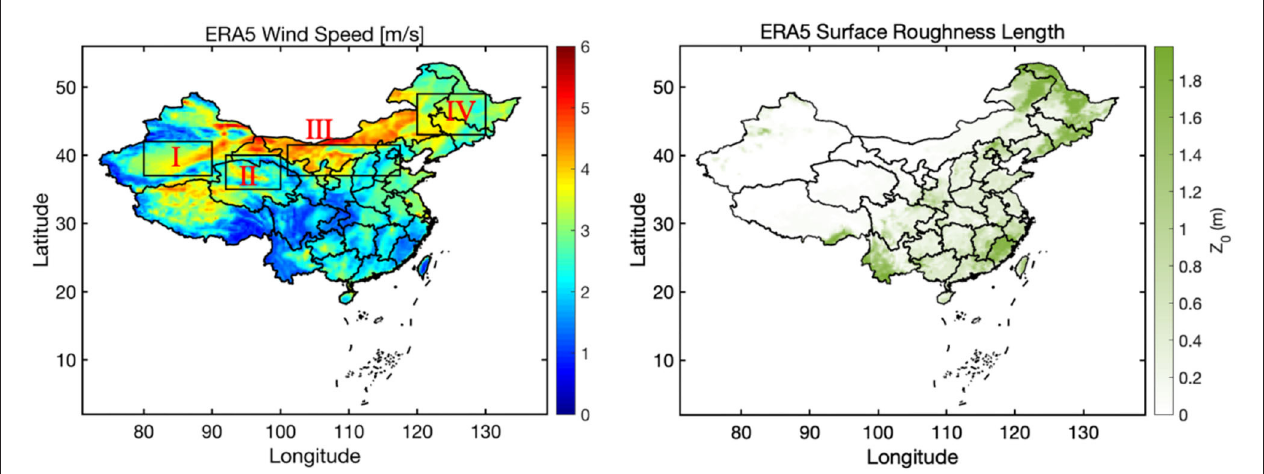
FIGURE 1 | The spatial distribution of multi-year (1986–2014) mean 10-m wind speed (left) and surface roughness length (right) over China. The four specific regions are shown as black